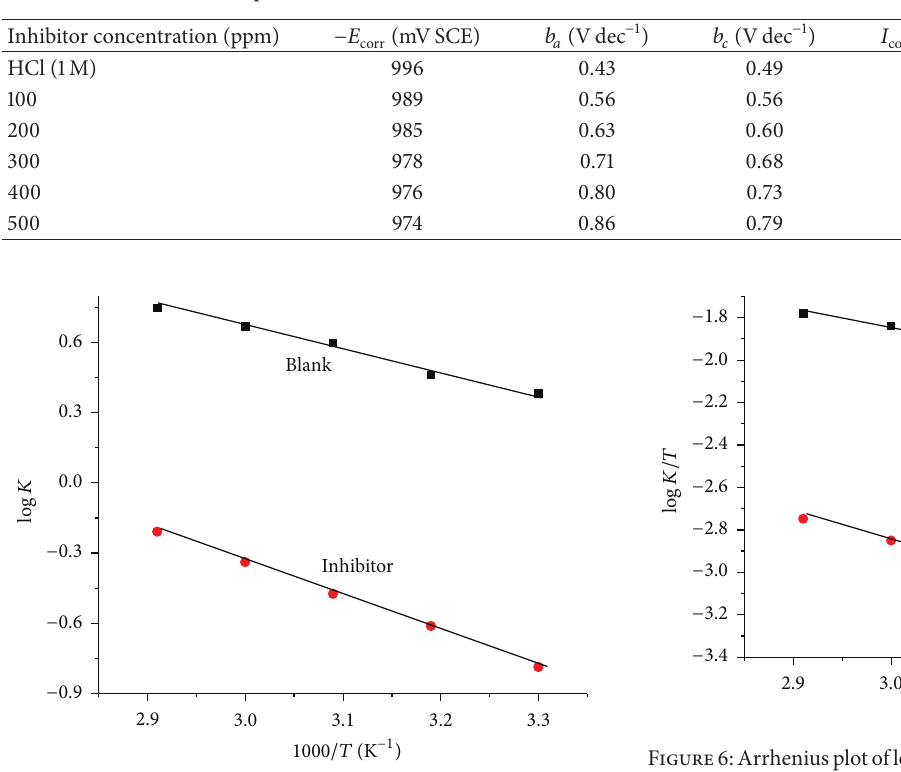
Figure 5: Relation between log 𝐾 and the reciprocal of the absolute temprature of zinc electrode in 1.0 M HCl devoid of and containing 500 ppm of Marjoram extract.